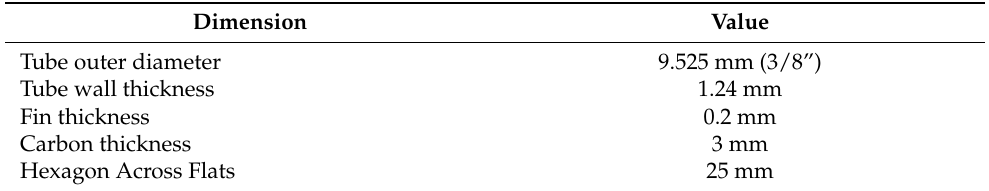
Figure 3. COP–SHP trade-off with a variation of parameters, ( a ) tube pitch, ( b ) aluminum fin thickness, and ( c ) carbon layer thickness. Table 1. Chosen geometry for module (and baseline values for comparisons).